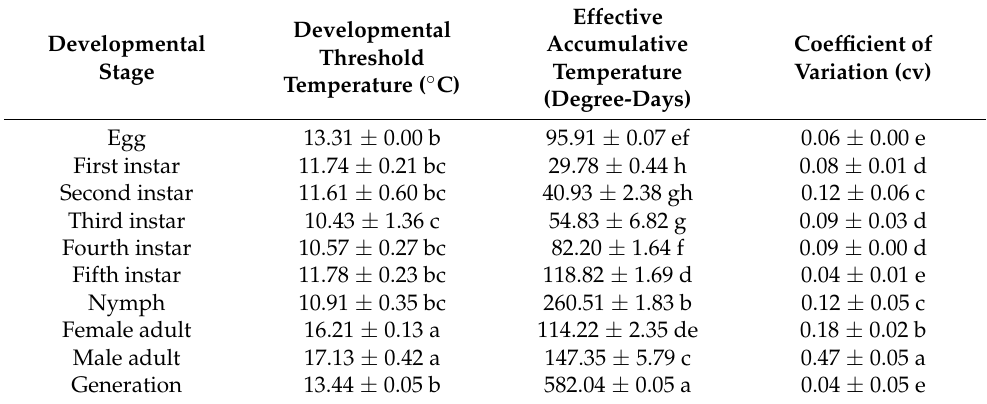
Table 2. Developmental threshold and effective accumulative temperature of Riptortus pedestris